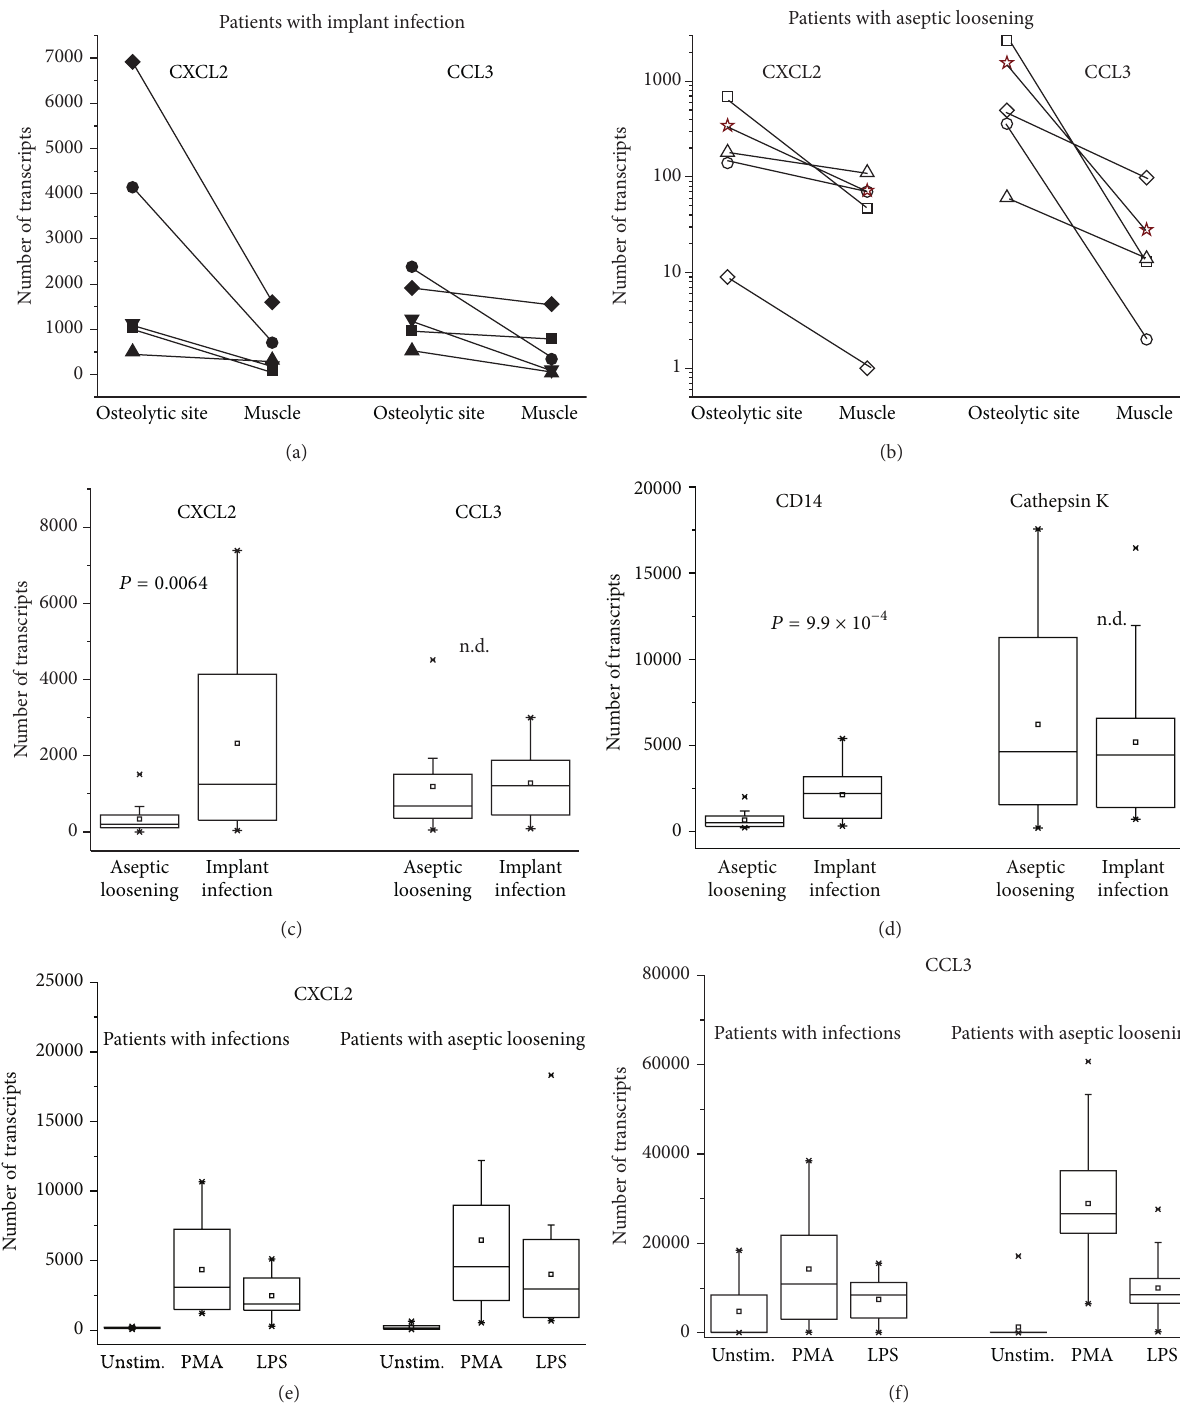
Figure 1: Gene expression of CXCL2 and CCL3 in tissue and blood of patients with implant-associated infection or aseptic loosening. Gene expression of CXCL2 and CCL3 was determined by qRT-PCR in tissue of patients with infection (a) or with aseptic loosening (b). Samples were collected from osteolytic sites and for comparison from muscle. Each symbol represents one patient. (c) Gene expression at osteolytic sites was compared between patients with implant infection ( 𝑛 = 6 ) and patients with aseptic loosening ( 𝑛 = 14 ), as was expression of CD14 and cathepsin K (d). The groups were analysed by Mann-Whitney test, and the respective 𝑃 values are given. (e, f) Gene expression was analysed in blood samples obtained from patients with infection and those with aseptic loosening. Basic expression of CXCL2 and CCL3 did not differ between the groups, and cells could be stimulated to a similar